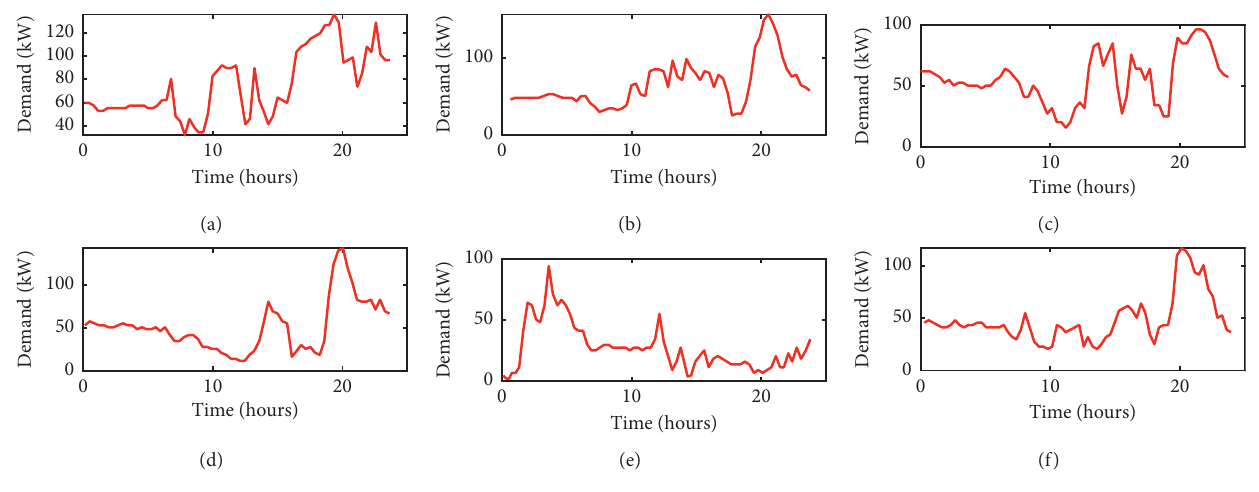
Figure 3: Different load